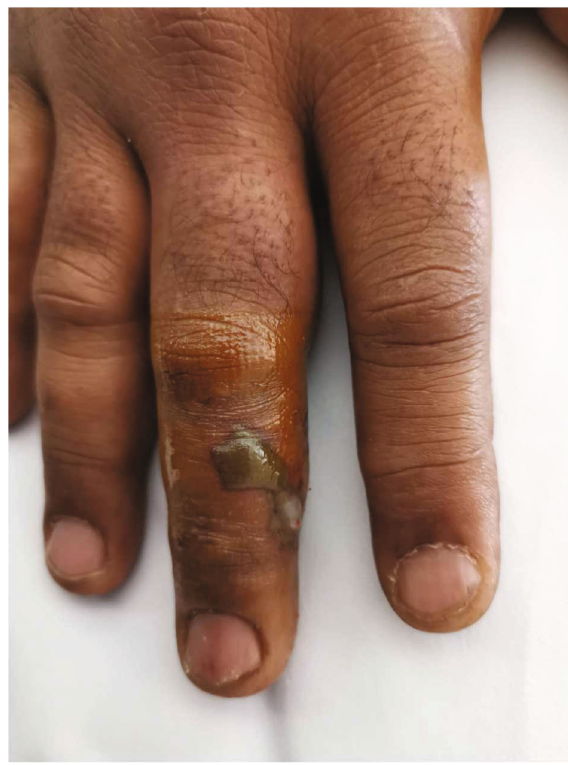
Figure 1: Snakebite of the middle fi nger. Table 1: The results of investigations carried out on